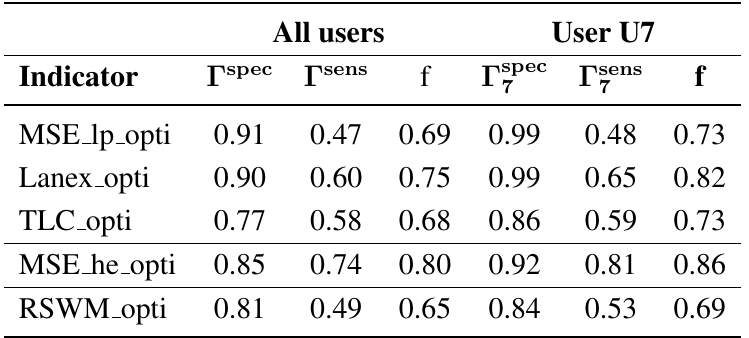
Table 5. Indicators with optimization